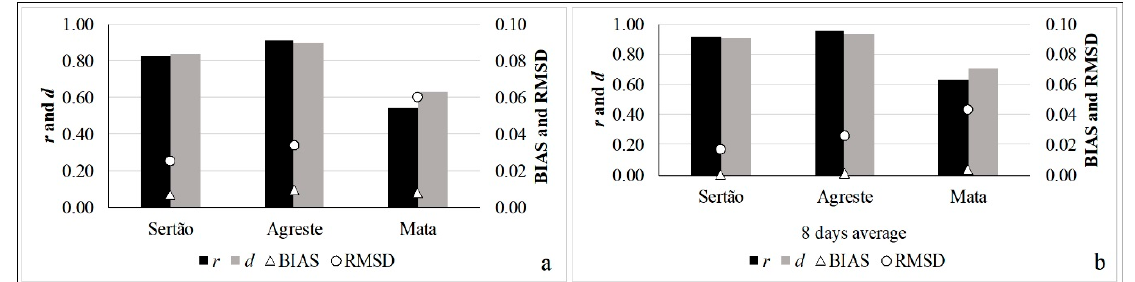
Figure 7. Statistical criteria values for the regions in Pernambuco considering ( a ) daily and ( b ) eight-day time intervals. The number of samples for daily and eight-day intervals were 654 and 96 for Sertão and Agreste, and 630 and 95 for Mata, respectively.